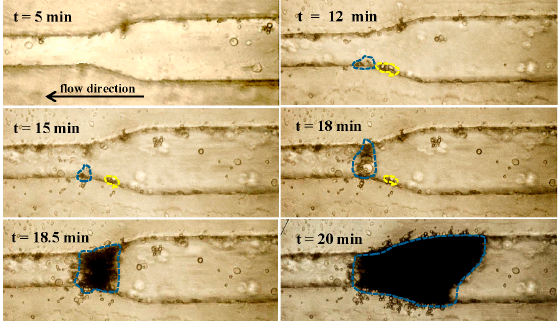
Figure 6. The representative photos of gradual microparticle clogging around the constriction region (15°) in a microchannel with an inlet of 100 μ m and outlet of 50 μ m. The blue dashes represent the area of permanently-deposited particles while the yellow dots show the detachment of initially-deposited particles at t = 18.5 min.